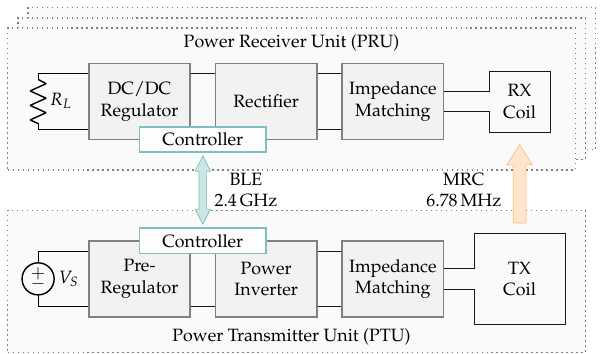
Figure 28. AirFuel Resonance system representation with one PTU and multiple PRUs